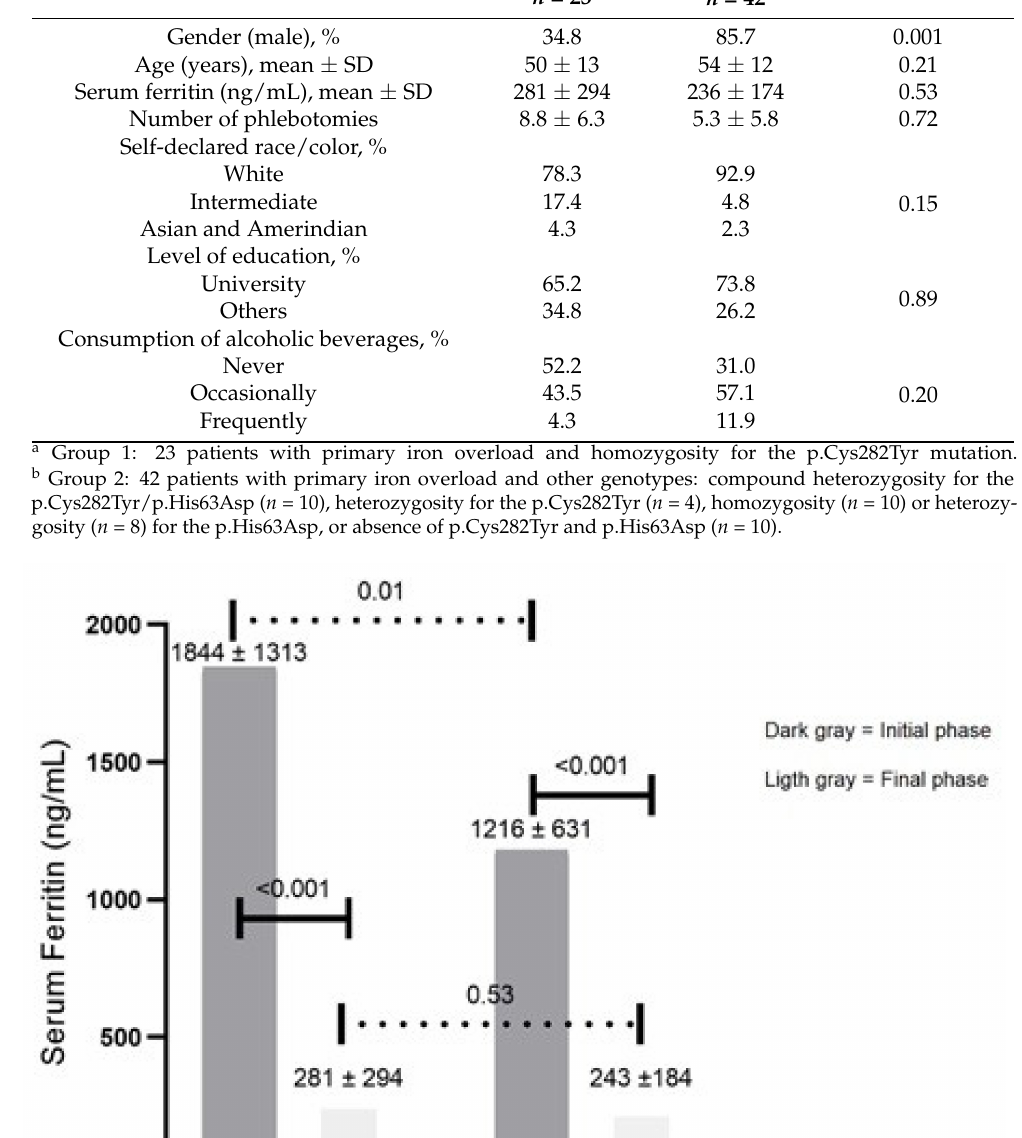
Table 1. General characteristics of follow-up according to patient genotypic groups.